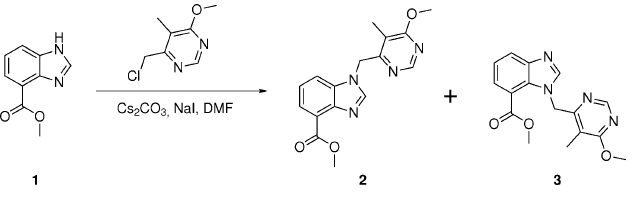
Figure 1 N -Alkylation of 1 with 4-(chloromethyl)-6-methoxy-5-methylpyrimidine to yield structural isomers 2 and 3 .